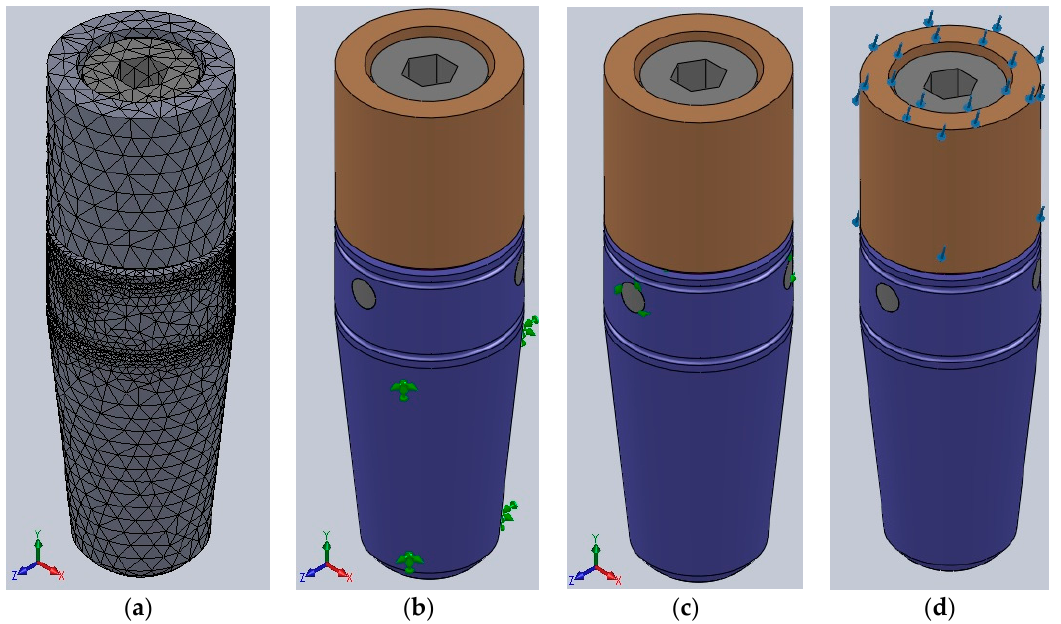
Figure 6. ( a ) Implant’s 3D model discretization into finite elements; ( b ) blocking of the outer surface of the implant; ( c ) adherent contact between the implant’s components; and ( d ) force